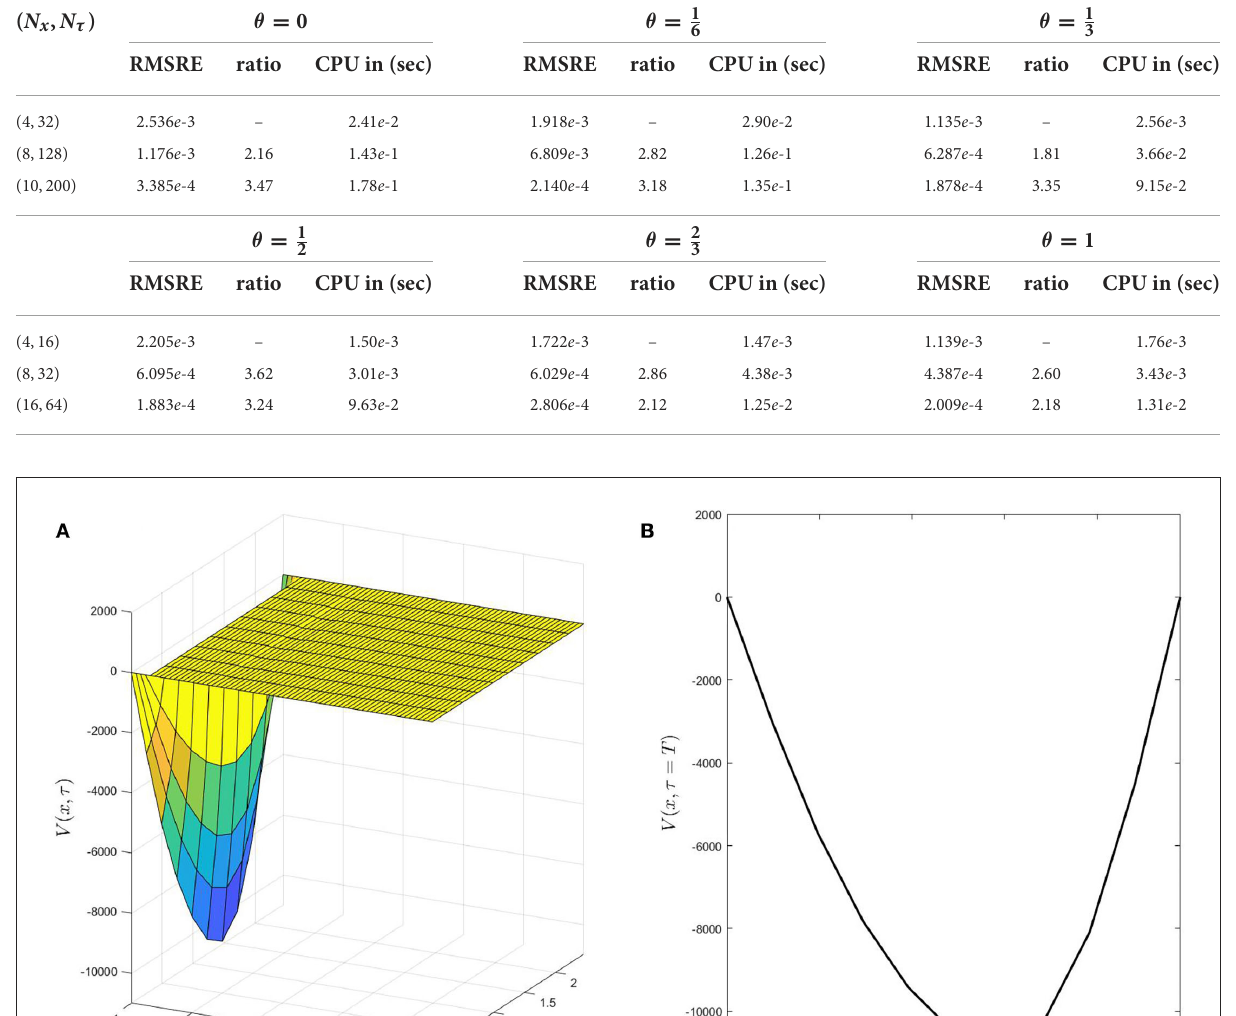
TABLE 6 The RMSRE of five distinct spatial nods, their ratios, and elapsed time computations for all cases of the θ -parameter of Example 3.